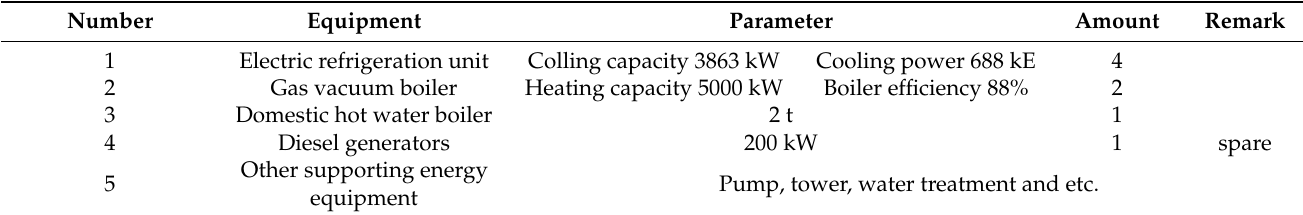
Table A1. Traditional system main equipment.